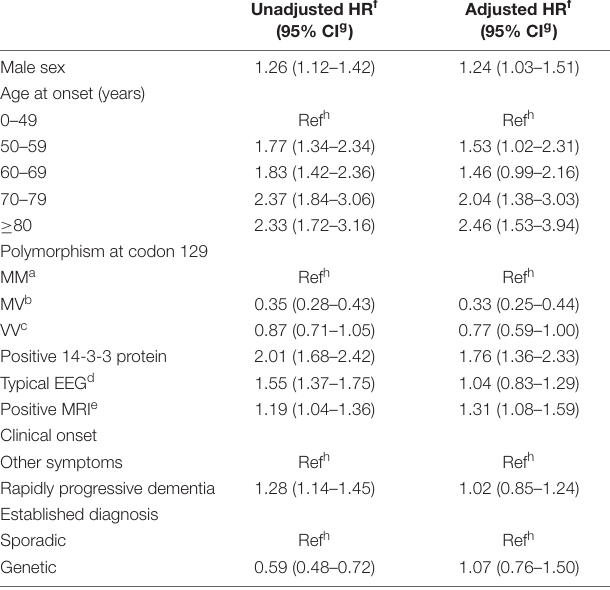
TABLE 2 | Univariate and multivariate Cox regression analysis for total cases ( n = 1,530).